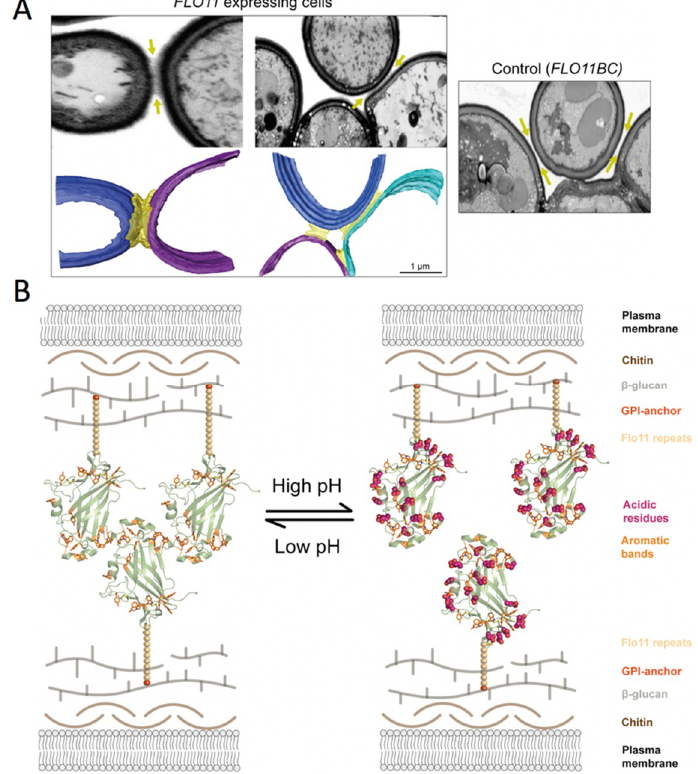
Figure 8. ( A ) Ultrastructural view and model of cell-cell contact sites with spacing as provided by Flo11p-Flo11p interactions. The electron microscopy photographs depict the filamentous nature of the cell-cell contacts (arrows). Three-dimensional (3D) reconstructions of the cell walls from different FLO11 -expressing cells are shown in blue, cyan, and purple, while the Flo11p-Flo11p interaction layer is shown in yellow. The control cells lacking the Flo11 adhesin domain (right) demonstrate the lack of intercellular filamentous structures at the cell-cell contacts (arrow). ( B ) Model of Flo11p–Flo11p interactions where N-Flo11p–N-Flo11p cluster in an oriented way by the interaction of the aromatic bands, which is pH-dependent. Reprinted with permission from [64].